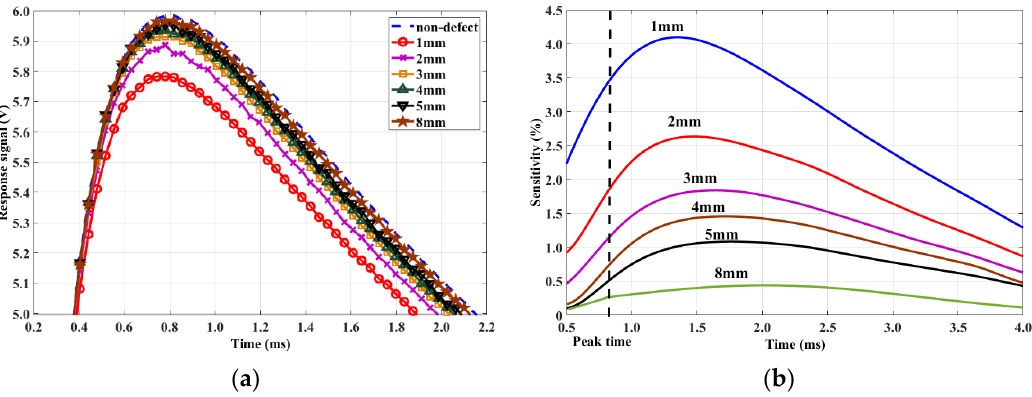
Figure 6. ( a ) Response signals of reverse defects and ( b ) signal sensitivity.